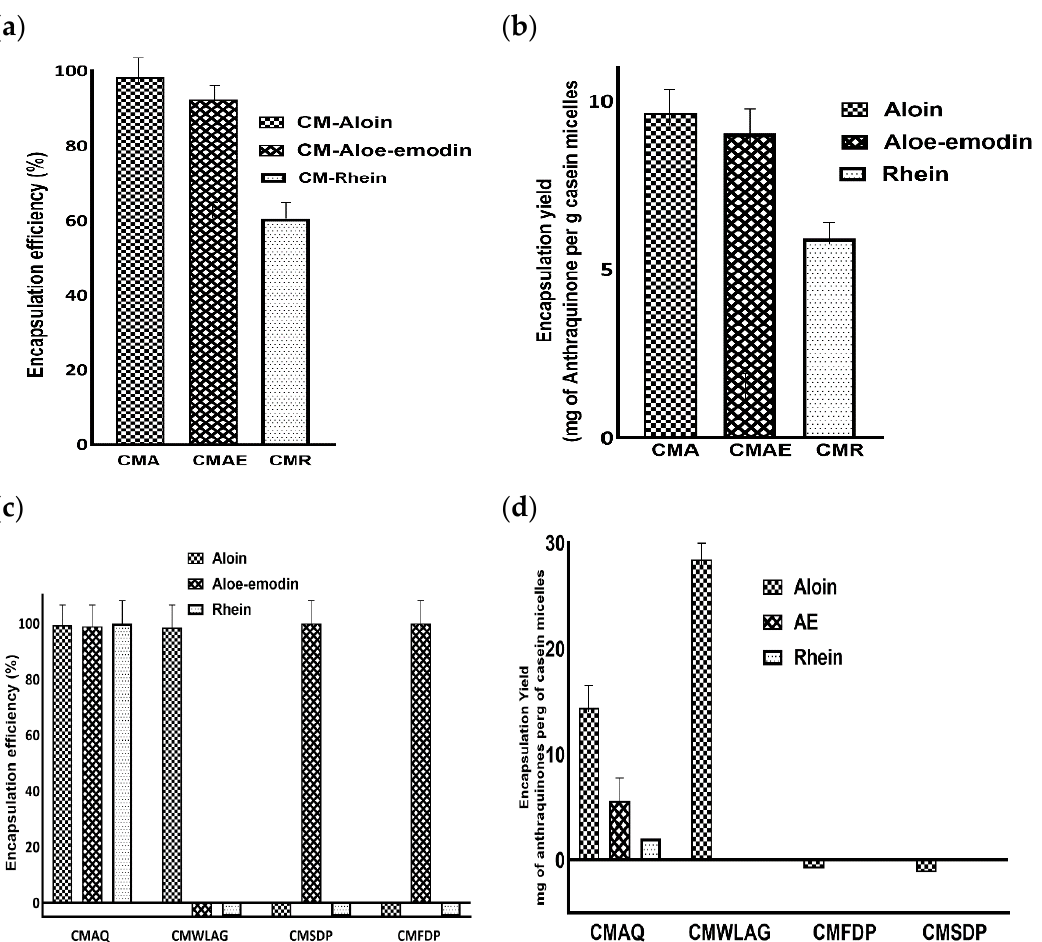
Figure 2. Plot of encapsulation efficiency (EE%) and encapsulation yield (EY) of casein micelles loaded with pure aloin, aloe-emodin, rhein ( a , b ) and encapsulation efficiency (EE%) and encapsulation yield (EY) of casein micelles after loading of Anthraquinones (aloin, aloe-emodin, rhein) from various samples of Aloe vera (AQ, FDP, SDP and WLAG) ( c , d ). Table 2. Mean particle size and zeta potential of controlled casein micelles (CM); with sonication) and casein micelles-loaded with anthraquinones (CM-aloin, CMAE (aloe-emodin), CMR (rhein), CMAQ (anthraquinones), CMFDP (freeze-dried powder), CMSDP (spray dried powder), CMWLAG (whole leaf aloe vera gel).